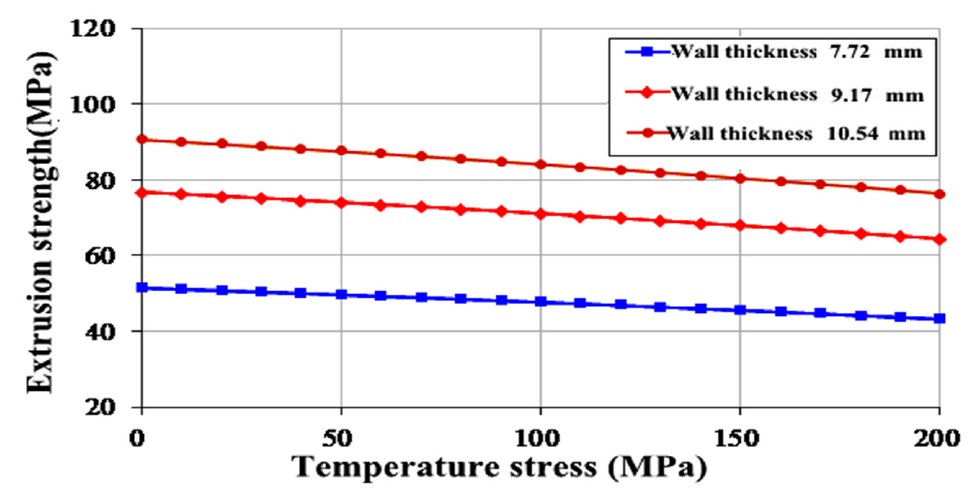
Figure 7. Casing collapse resistance under different temperature stress.